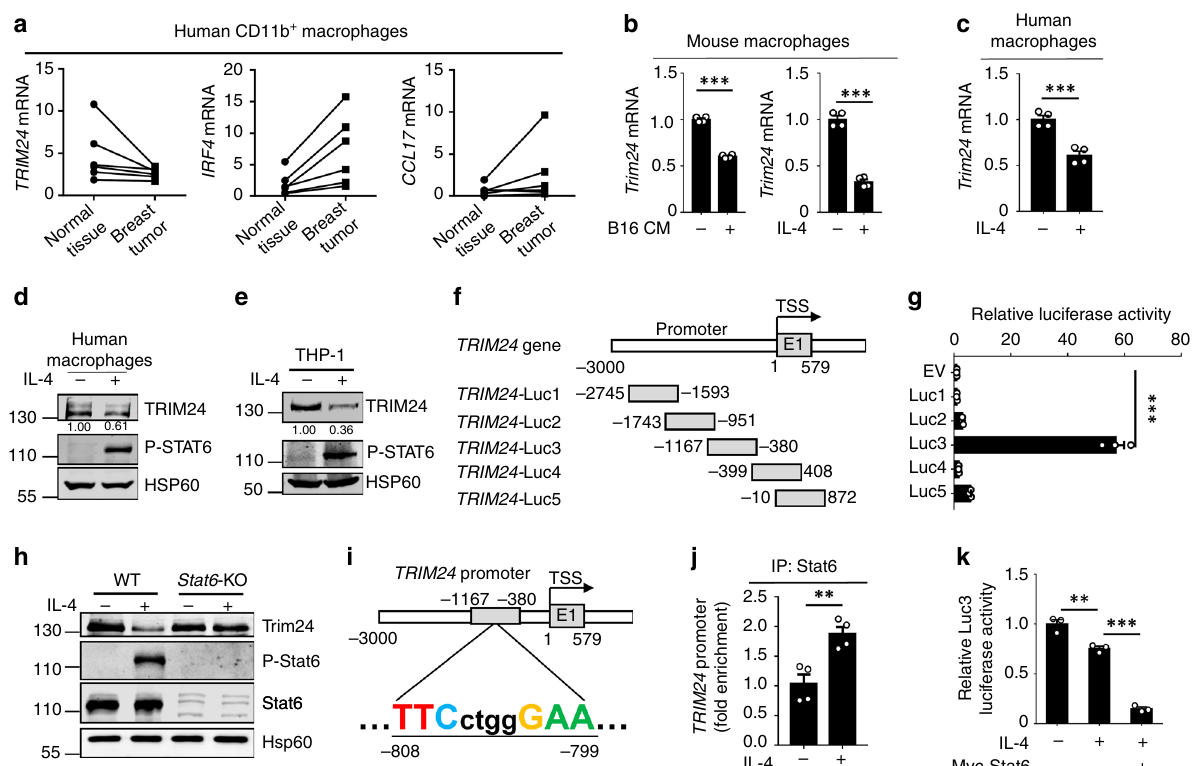
Fig. 8 Stat6-mediated direct transcriptional suppression of Trim24. a QPCR analysis of TRIM24 , IRF4 , or CCL17 mRNA expression in sorted CD11b + macrophages that isolated from six pairs of breast tumor and adjacent normal tissues from six breast cancer patients. b – e QPCR and immunoblot analysis of Trim24 gene expression in murine primary macrophages or in human PBMC-derived macrophages or in human THP-1 cells that were left nontreated ( − ) or stimulated ( + ) with a conditioned medium of B16 melanoma cells or IL-4 for 6 h. f , g Structure schema of the constructed luciferase reporters by using different truncated promoter sequences of TRIM24 gene, which were then used to test the luciferase activity. h Immunoblot of Trim24, phosphorylated (P), and total Stat6 and Hsp60 (loading control) expression in macrophages isolated from wild-type (WT) and Stat6 -de fi cient ( Stat6- KO) mice. i Schematic representation showing a Stat6-conserved binding site located in the promoter region of TRIM24 gene between – 1167 and – 380. j ChIP – QPCR analysis of the binding of STAT6 in the promoter region of TRIM24 gene in the THP-1 cells that were stimulated with ( + ) or without ( − ) IL-4 for 1 h. k Luciferase assay of Stat6-induced transcriptional suppression of TRIM24 in 293T cells that were transfected with the indicated expression vector, and then were stimulated with ( + ) or without ( − ) IL-4 for 4 h. Data with error bars are represented as mean ± SD. Each panel is a representative experiment of at least three independent biological replicates. ∗ p < 0.05, ∗∗ p < 0.01, ∗∗∗ p < 0.001 as determined by the unpaired Student ’ s t test. Source data are provided as a